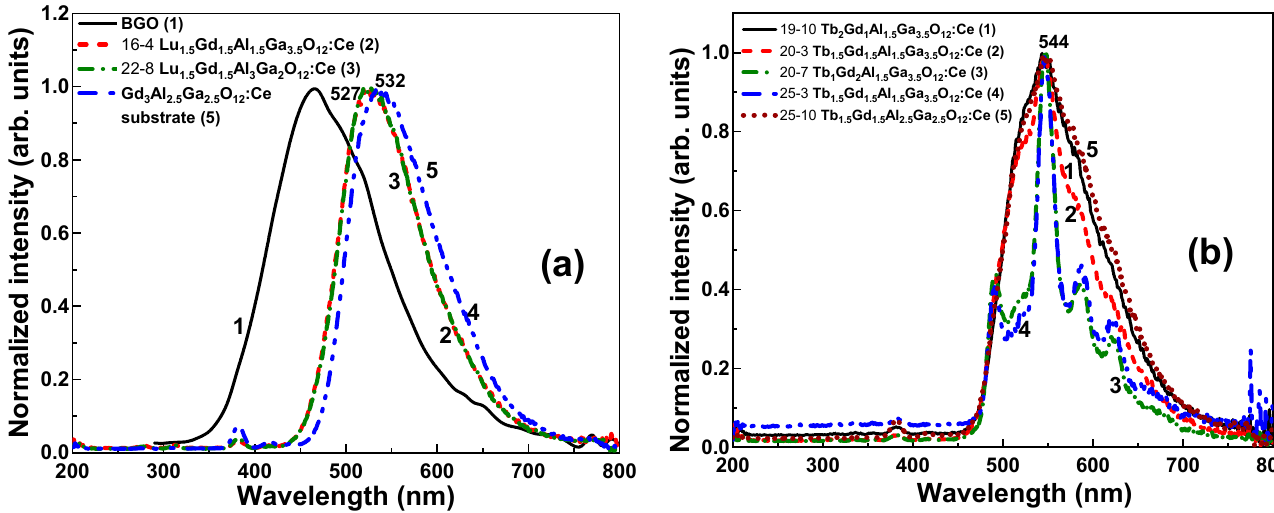
Figure 6. ( a ) Normalized XRL spectra of the selected Lu-Gd- ( a ) and Tb-Gd-based ( b ) composite scintillators in comparison with GAGG:Ce substrate and reference BGO scintillator. Table 3. Scintillation yield parameters of the selected composite